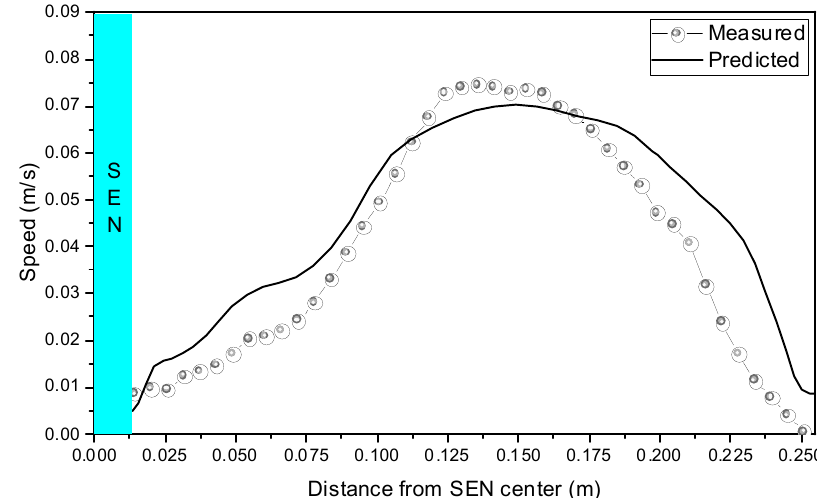
Figure 2. Comparison between the measured and the predicted result of the speed on the thickness centerline at 5 mm below the meniscus.